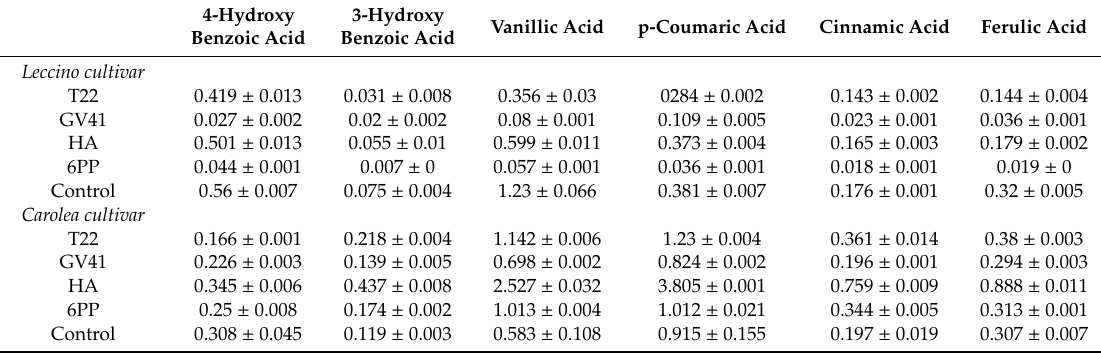
Table 7. Content of phenolic acids in EVOO (mg /